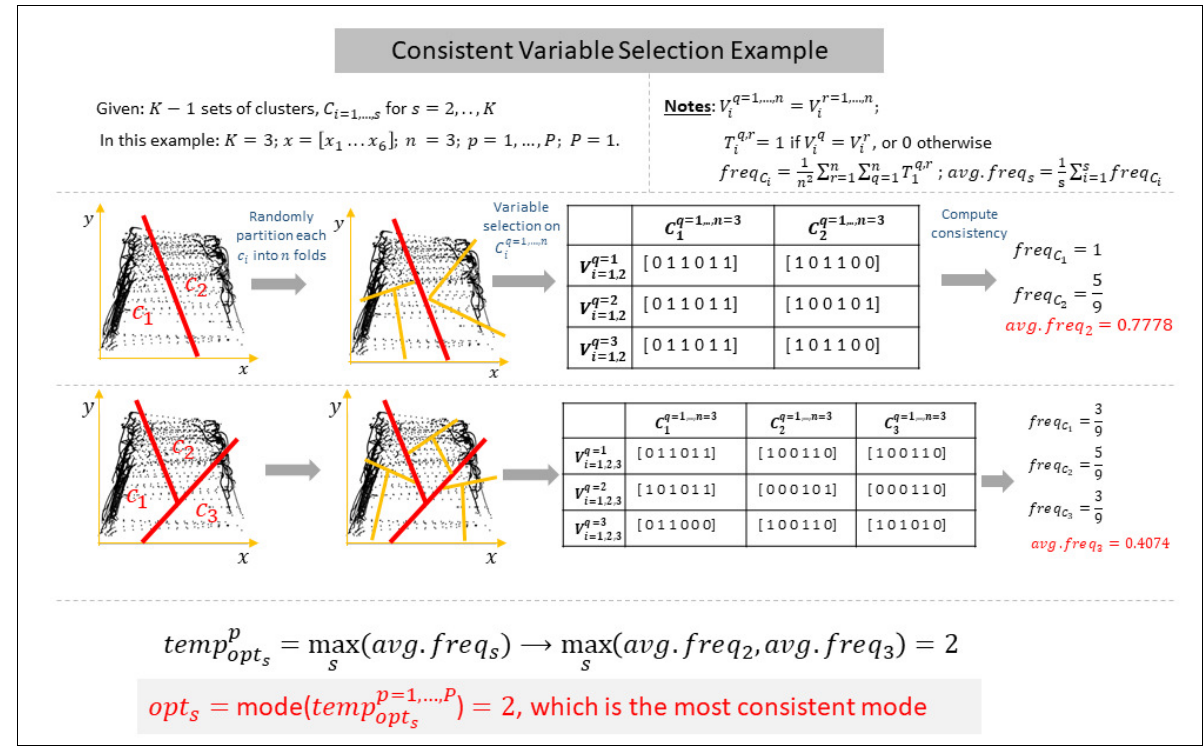
Figure 2. An example of selecting the optimal number of modes or sub-models using consistent variable selection, given 2 sets of